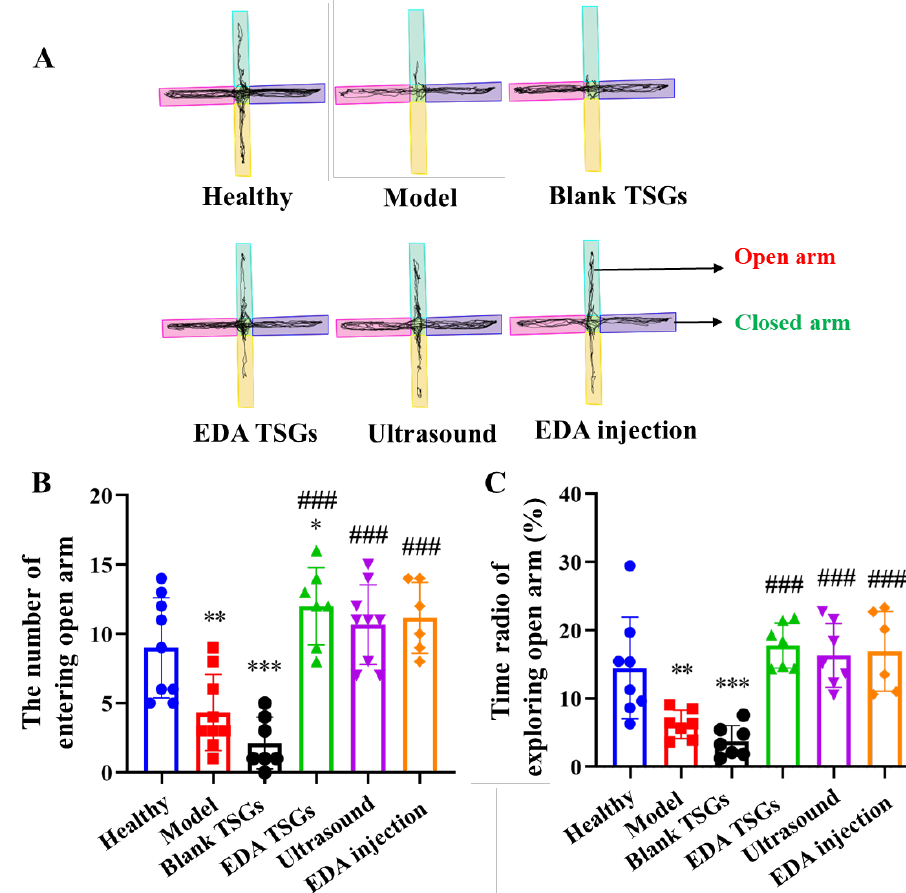
Figure 9. Comparison of anxiety behavior of mice in each group by the elevated plus maze test. The track map ( A ); Statistical data analysis of the number of entering open arm ( B ) and the time radio of exploring open arm ( C ). Data are represented as mean ± SD ( n = 10). *: means significant difference, vs. the healthy group, * p < 0.05, ** p < 0.01, *** p < 0.001; # : means significant difference, vs. the model group, ### p < 0.001.